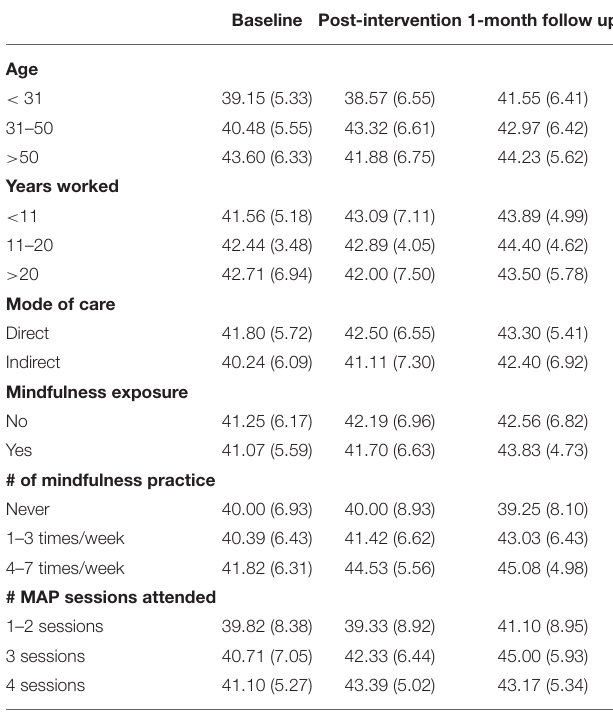
TABLE 1 | Resiliency score for three-time points based on participant characteristics and mindfulness related variables (mean,